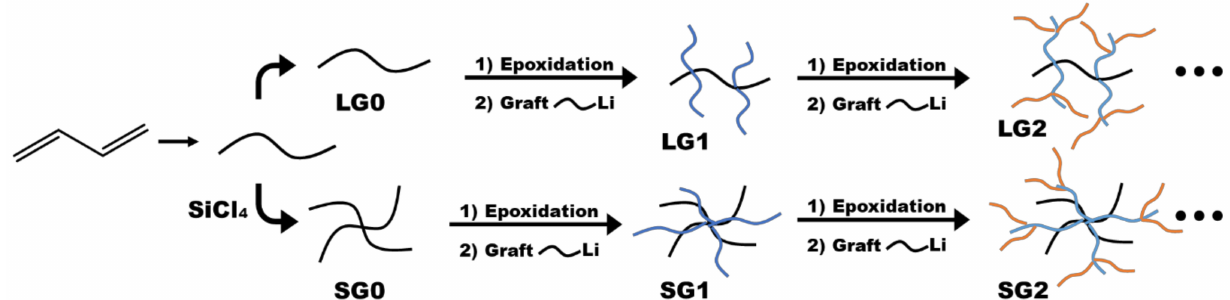
Figure 13. Synthetic routes of dendrigraft polybutadienes with linear-comb or star-comb architecture from generation 0 to 2. Figure adapted from